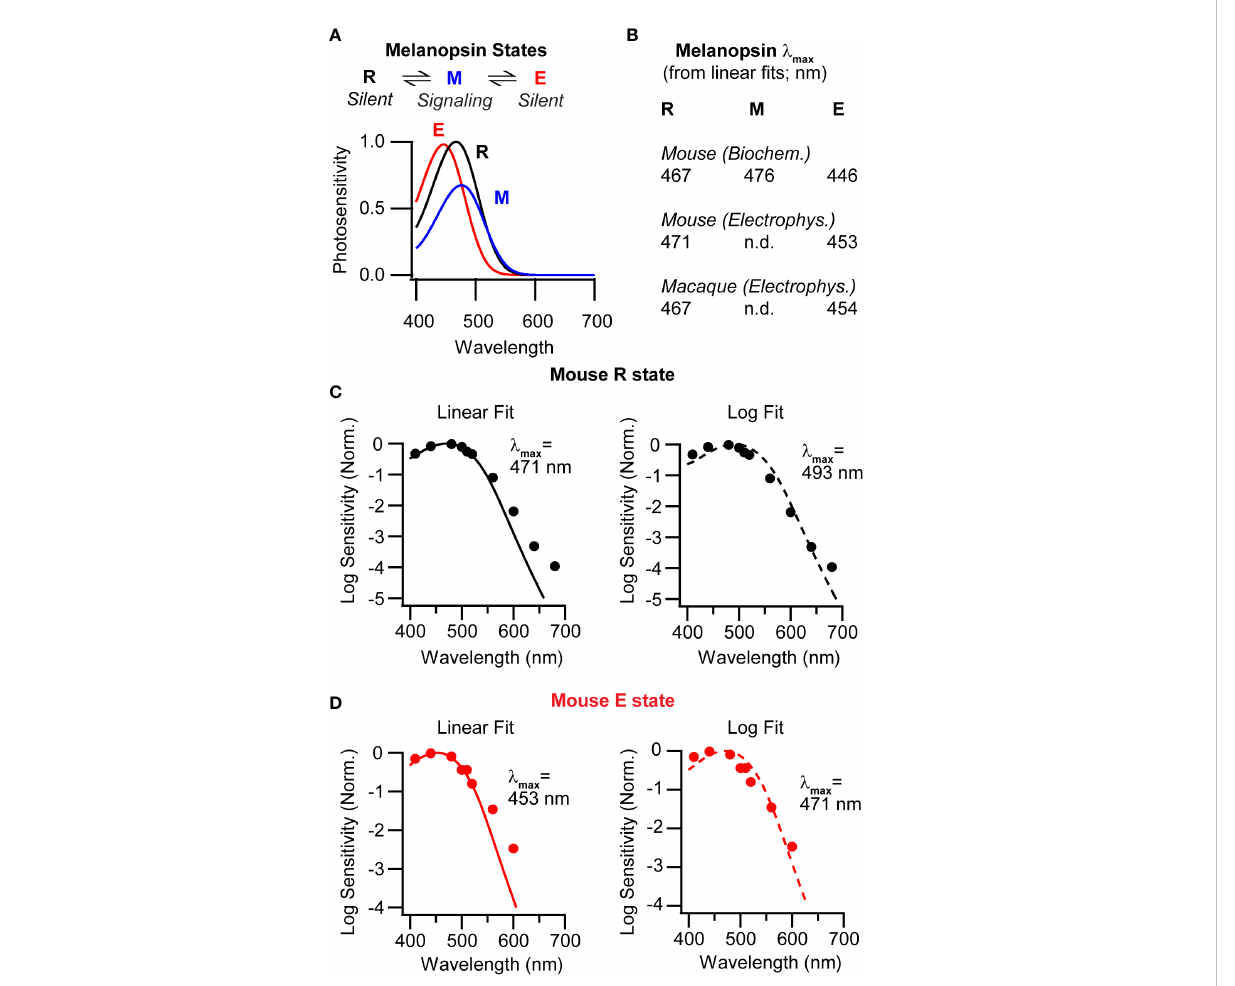
FIGURE 1 Melanopsin multistability in mice and macaques. (A) Top , Melanopsin states in the mouse. Melanopsin (R, the ground state, electrically silent) photoconverts with metamelanopsin (M, the signaling state), which photoconverts with extramelanopsin (E, electrically silent). Bottom , Photosensitivities of the three mouse melanopsin states (product of the extinction coef fi cient and quantum ef fi ciency of isomerization) as a function of wavelength (20), normalized to that of the R state. (B) Wavelengths of peak sensitivity ( l max ) for mouse melanopsin estimated by biochemistry and electrophysiology, and for macaque melanopsin estimated by electrophysiology (20 – 22). l max values were obtained by fi tting nomograms on linear ordinates. (C) Left , Average of action spectra measured from mouse ipRGCs in darkness (markers) Data were previously published (21). The line is